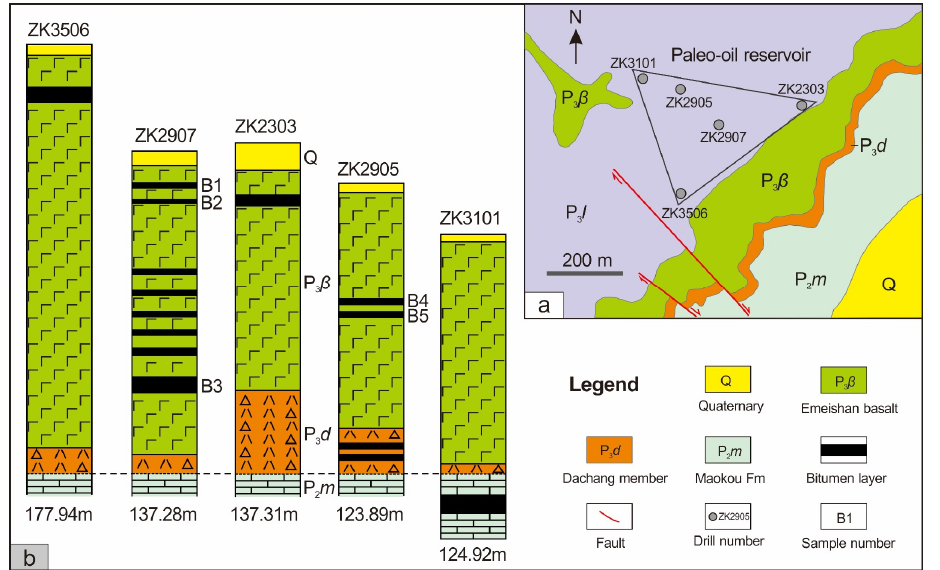
Figure 5. Sketch map of the location of the five boreholes ( a ) and drill columns ( b ) in Qinglong antimony ore field (modified after [ 38 ]).